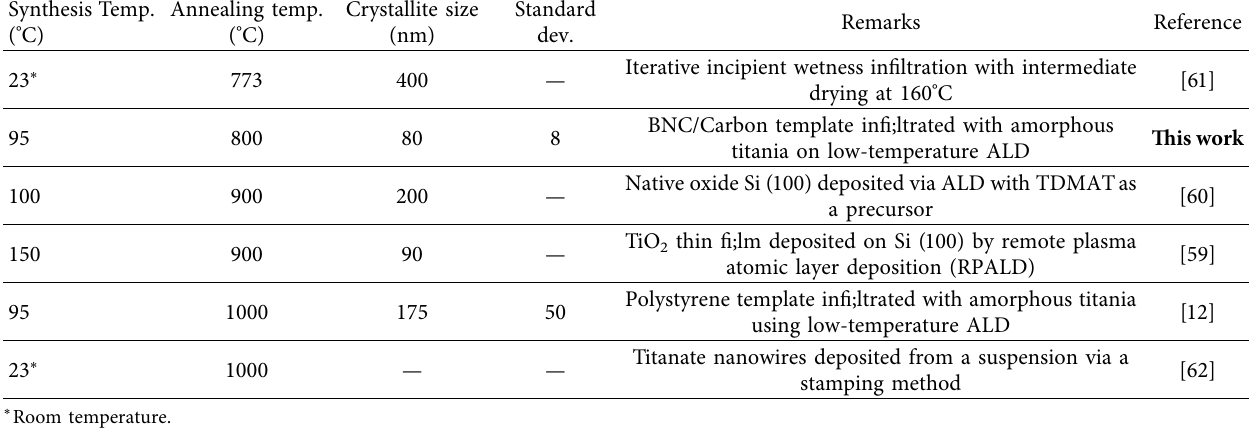
Table 2: Summary of anatase-stabilized titania sorted by annealing temperature. Synthesis Temp.